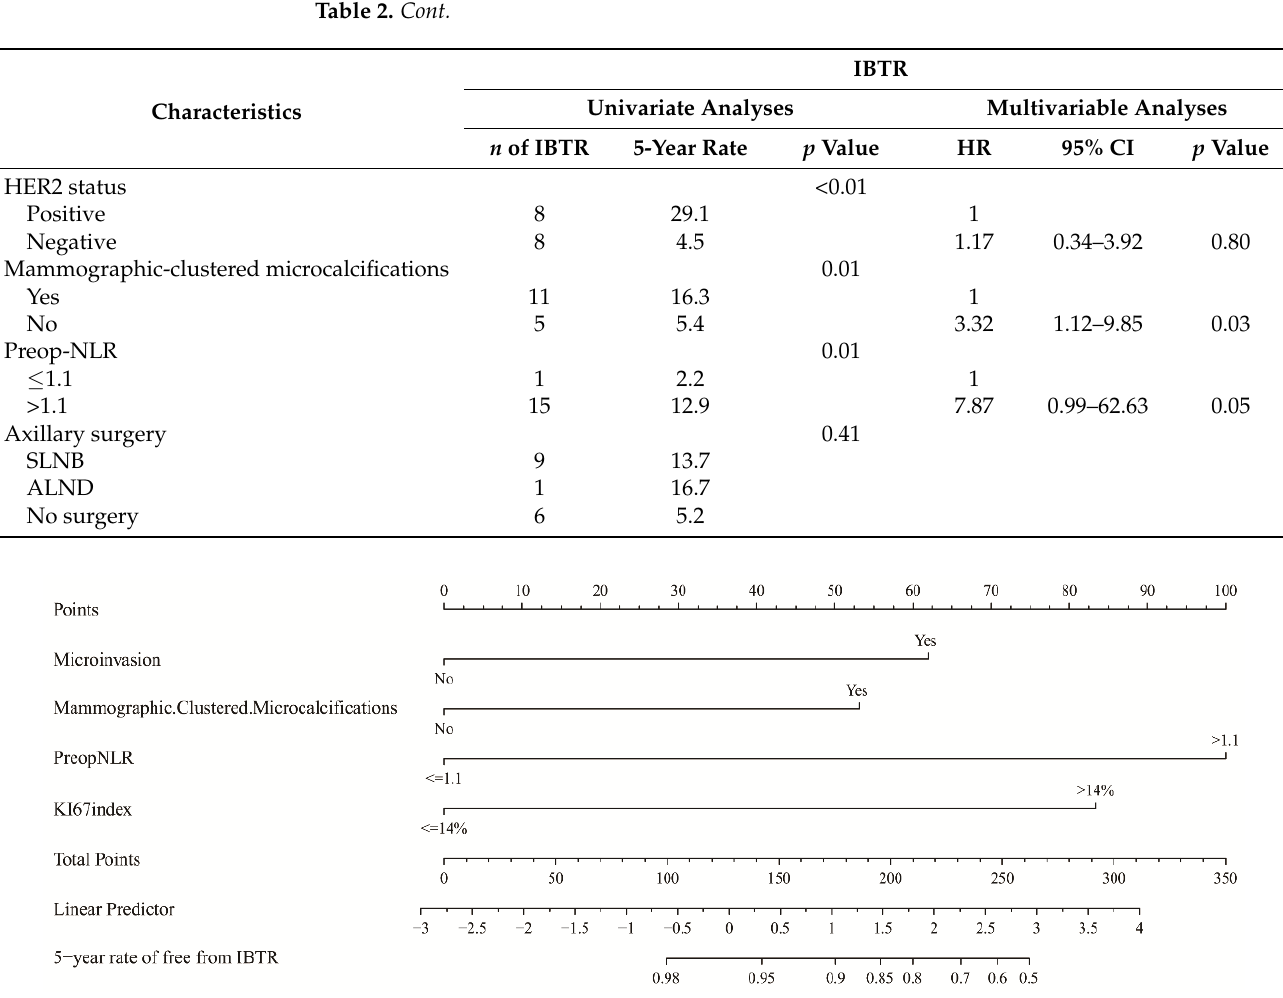
Figure 1. Nomogram for predicting 5-year IBTR in the training cohort. Abbreviations: IBTR = ipsilateral breast tumour recurrence; NLR = neutrophil/lymphocyte ratio.